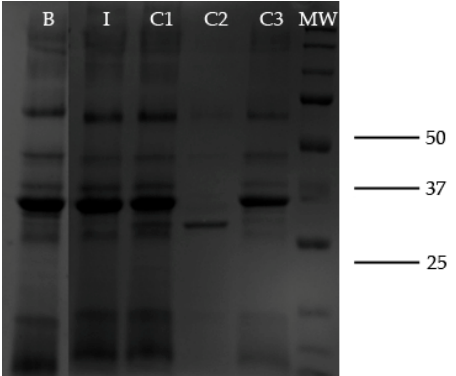
Figure 6. SDS-PAGE analysis of the samples from the proteolysis study. ( B ) The initial solution of proROL lipase. ( I ) proROL solution after 24 h in the presence of inhibitor. ( C1 ) proROL solution after 24 h in the presence of ethanol. ( C2 ) proROL solution in 5 mM phosphate buffer after 24 h. ( C3 ) Sterilized proROL solution in 5 mM phosphate buffer after 24 h. ( MW ) Molecular weight marker.